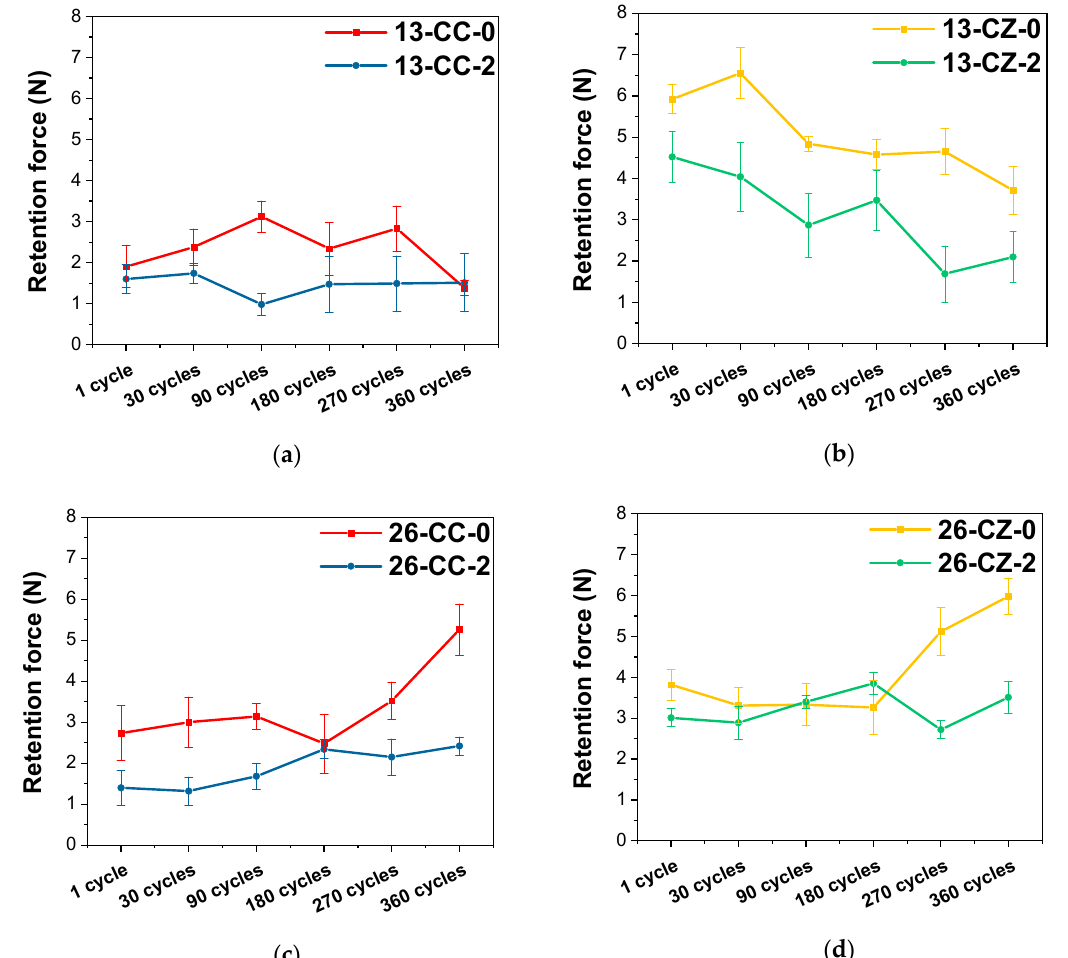
Figure 7. Evolution of the retention forces as a function of the tapper angle used in the manufacturing the telescopic system. ( a ) tooth 1.3—Co–Cr alloy for both crowns; ( b ) tooth 1.3—Co-Cr alloy for secondary crown and ZrO 2 for primary crown; ( c ) tooth 2.6—Co–Cr alloy for both crowns and ( d ) tooth 2.6 —Co–Cr alloy for secondary crown and ZrO 2 for primary crown.